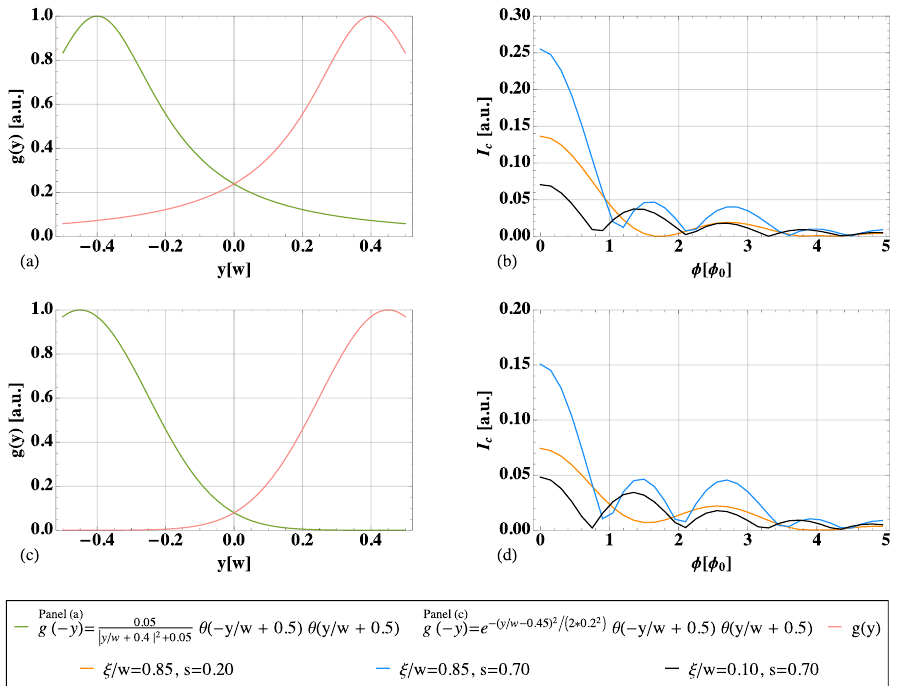
Figure 5. Flux-dependence of the critical supercurrent considering different values of coherence length, a more or less prevalent role played by LARs and CARs (represented by the parameter s ), and different profiles for the edge states. In each row, the first panel ( a , c ) shows profile g ( y ) and the symmetric g ( − y ) . In the second column (panels ( b , d )), the full interference pattern, arising from both LARs and CARs, is plotted. Different colors are associated with different values of ξ and s ; see the plot